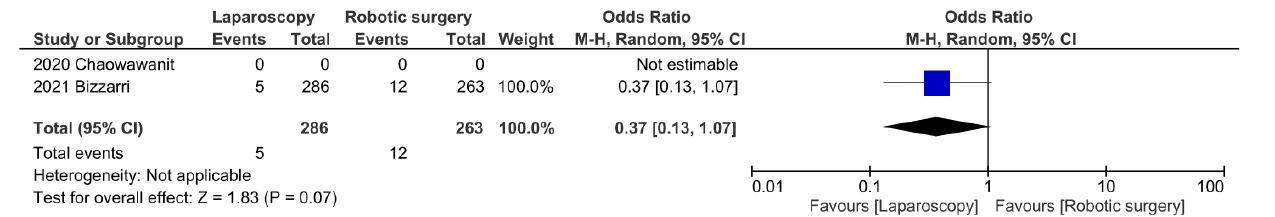
Figure 11. Forest plot of individual and pooled odds ratios, with 95% confidence interval (CI), for postoperative complications, comparing laparoscopy and robotic surgery for SLN biopsy in EC women.